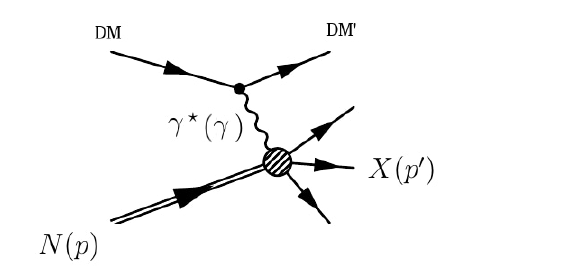
Figure A1. DIS of LDM on nucleus